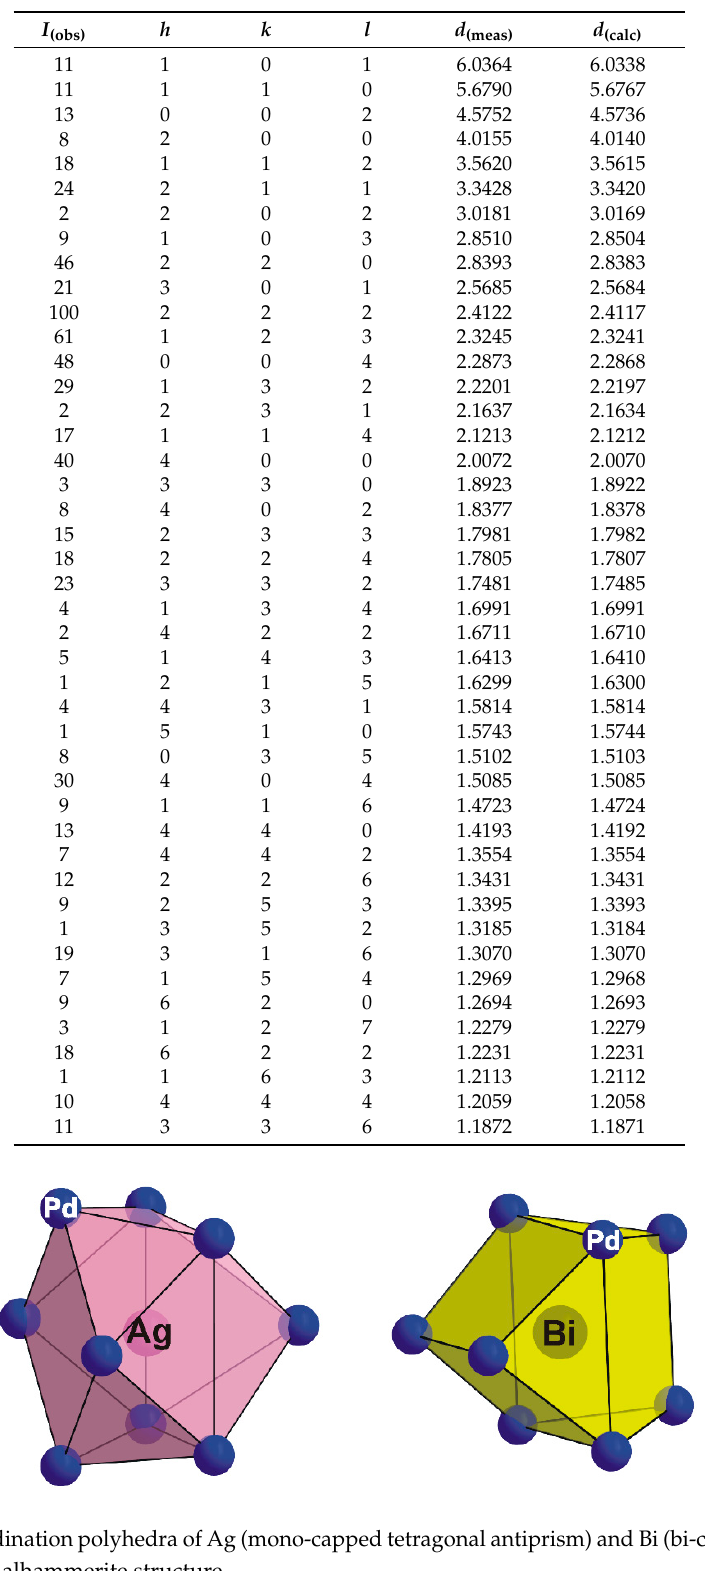
Table 6. X-ray powder diffraction data of thalhammerite (Cu K α radiation, Bruker D8 Advance, Bragg-Brentano geometry). Only reflections with I (obs) ≥ 1 are listed.